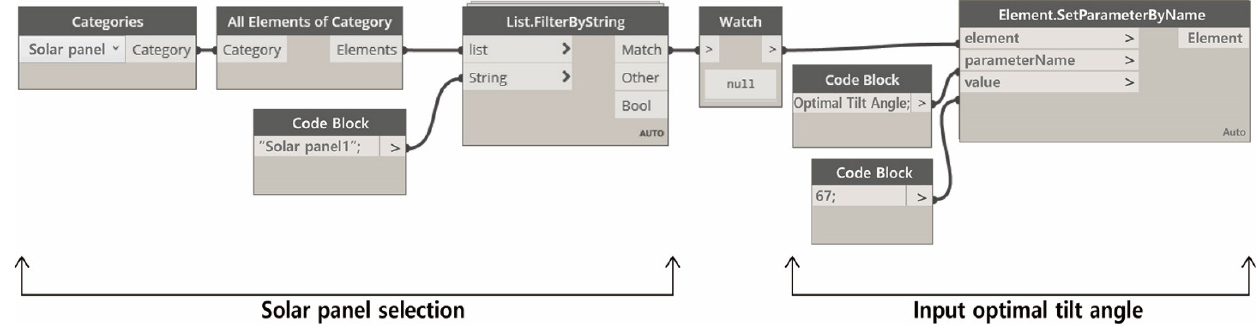
Figure 5. Algorithm input to the optimal tilt angle (67°) in “Solar Panel1”.